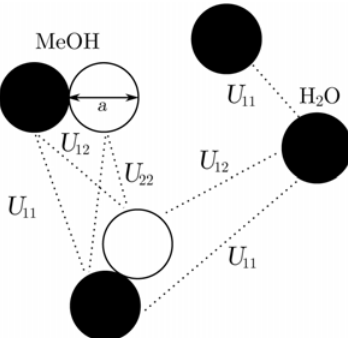
Figure 1: Methanol is modelled as two tangential spheres, repre- senting the hydroxyl (black) and methyl (white) groups. Water is modelled as a sphere (black). Interactions between black particles is described by the CSW potential, other interactions are Lennard- Jonesian.